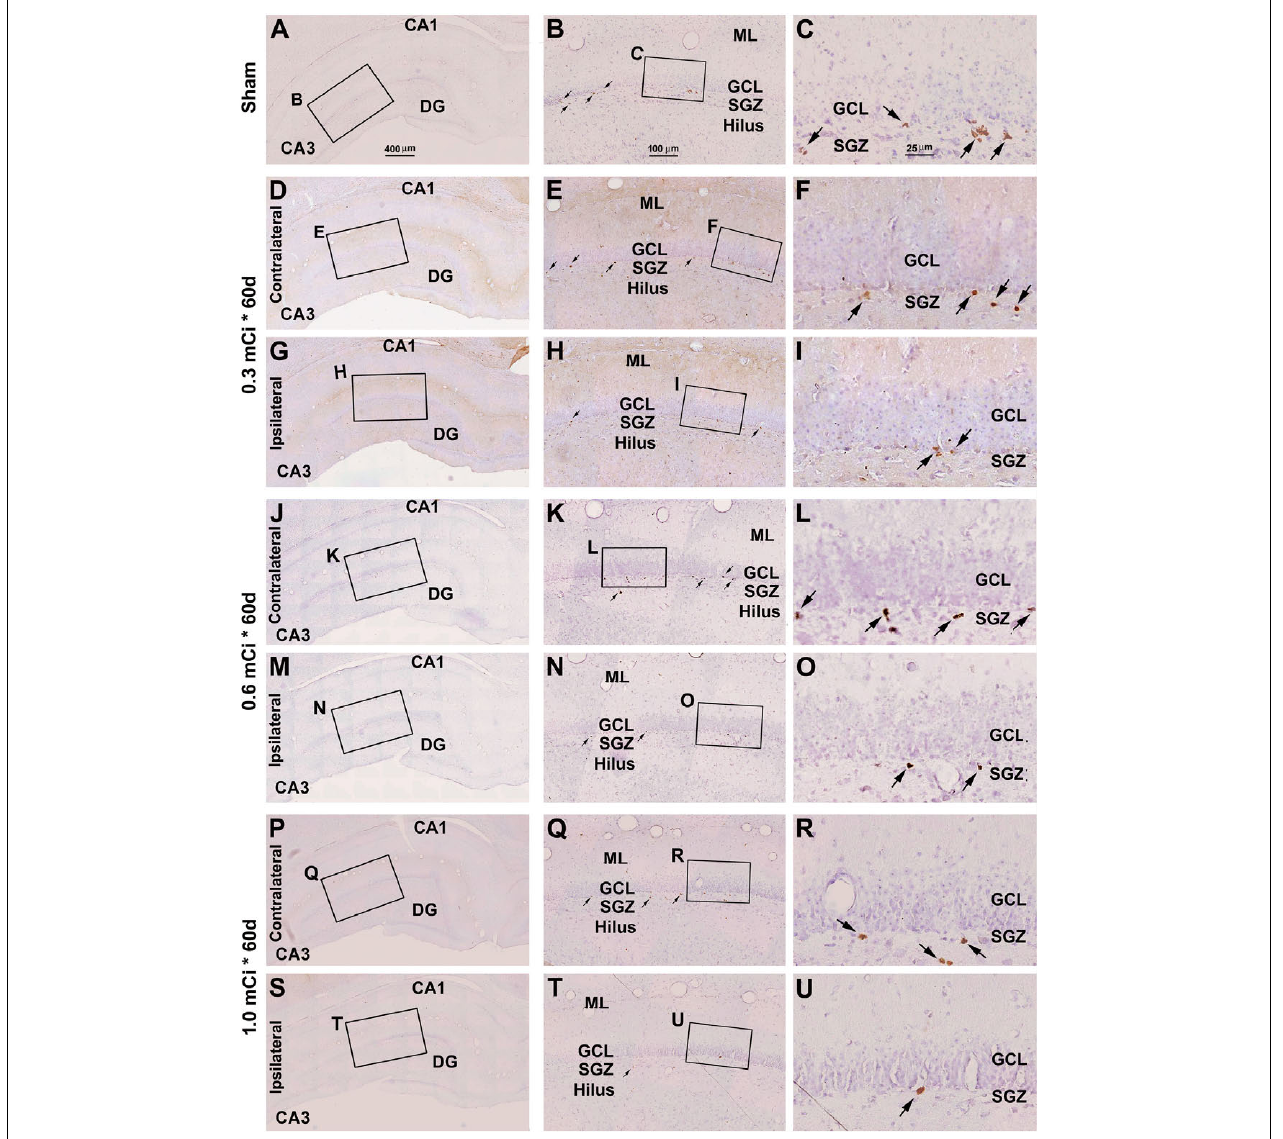
FIGURE 5 | Effect of 0.3- to 1.0-mCi 125 I seed radiation on Ki67 + cells of the hippocampal dentate gyrus at 60 days postsurgery. Representative images of Ki67 immunolabeling (brown) with hematoxylin counterstain (blue) from individual animal groups are as indicated. The left panels (A,D,G,J,M,P,S) are low-magnification images, with framed areas enlarged sequentially as the middle and right panels, as indicated. The amount of Ki67 + cells (pointed by arrows) in the SGZ is reduced in the radiation groups (H,I,N,O,T,U) relative to the sham control. Abbreviations are as defined in Figure 2 . Scale bar = 400 µ m in (A) applying to (D,G,J,M,P) ; equal to 100 µ m for (B,E,H,K,N,Q) ; and 25 µ m for (C,F,I,L,O,R)